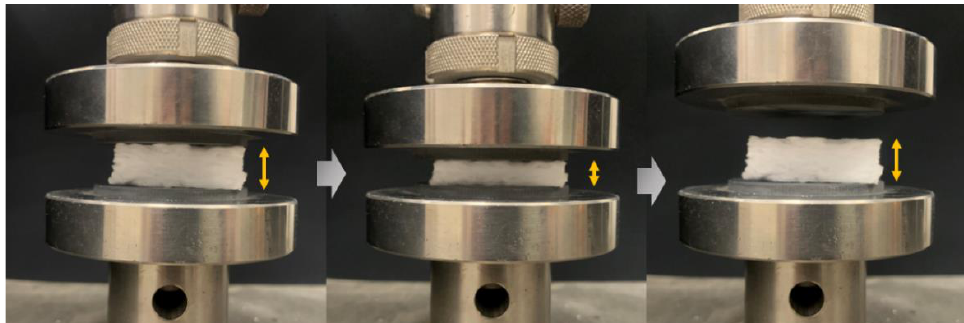
Figure 7. Image of the compression test for the SiO 2 fibrous porous material under 50% applied strain (resilience ratio > 95%).